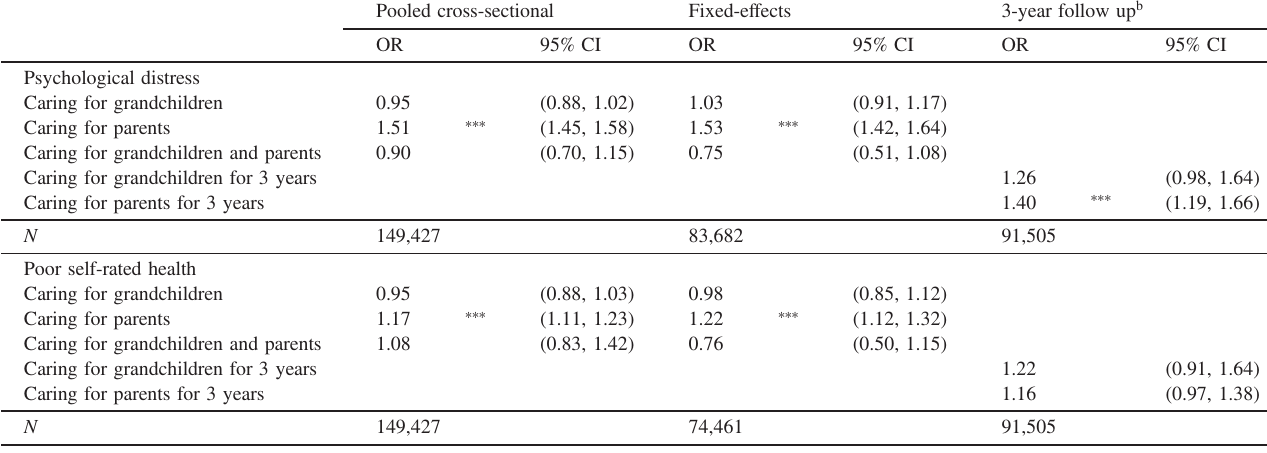
Pooled cross-sectional Fixed-e ff ects 3-year follow up